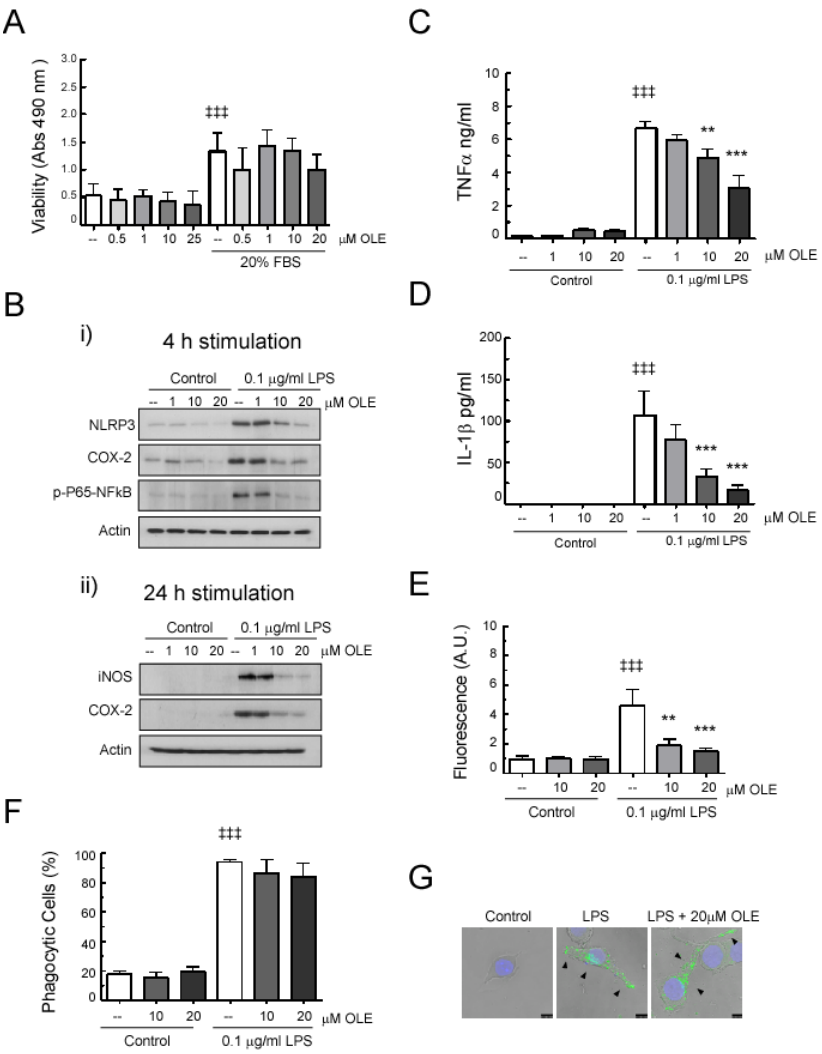
Figure 6. Oleacein treatment modulates BV-2 microglia cell activation. BV-2 cells were pretreated for 30 min with the indicated doses of OLE. ( A ) Cell viability was assayed after 24 h of incubation in the absence or presence of 20% FBS ( ‡‡‡ p < 0.001 vs. without FBS; n = 3). ( B ) After 4 h ( i ) or 24 h ( ii ) of stimulation with 0.1 μg/mL of LPS, COX-2, iNOS, phosho-p65-NFκB and NLRP3 expression was identified in cell lysates by Western blot, and ( C ) the presence of TNFα and ( D ) IL-1β in the 24 h cell culture medium was quantified by commercial ELISA ( ‡‡‡ p < 0.001 vs. control, *** p < 0.001 and ** p < 0.01 vs. stimuli without OLE; n = 3). ( E ) After 24 h of stimulation with 0.1 μg/mL of LPS, intracellular ROS production was evaluated by Flow cytometry analysis: Bar graph shows quantification expressed in arbitrary units (A.U.) ( ‡‡‡ p < 0.001 vs. control; *** p < 0.001 and ** p < 0.01 vs. stimuli without OLE; n = 3). ( F , G ) After 24 h of stimulation with 0.1 μg/mL of LPS, cells were incubated with 1 mg / mL of FITC-labelled dextran, and phagocytosis was measured by Flow cytometry analysis: Bar graph shows percentage of BV2 cells expressing phagocytic activity. Representative confocal microphotographs of cells are shown, verifying that green fluorescent (FITC-dextran) associated with BV-2 microglia is localized inside of the cells (arrowheads). ‡‡‡ p < 0.001 vs. control ( n =